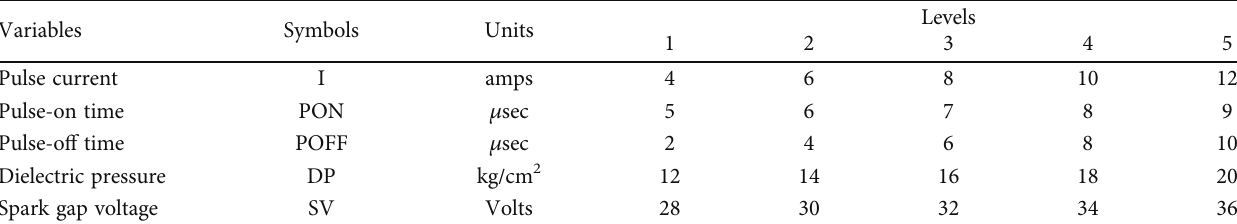
Table 1: Experimental input